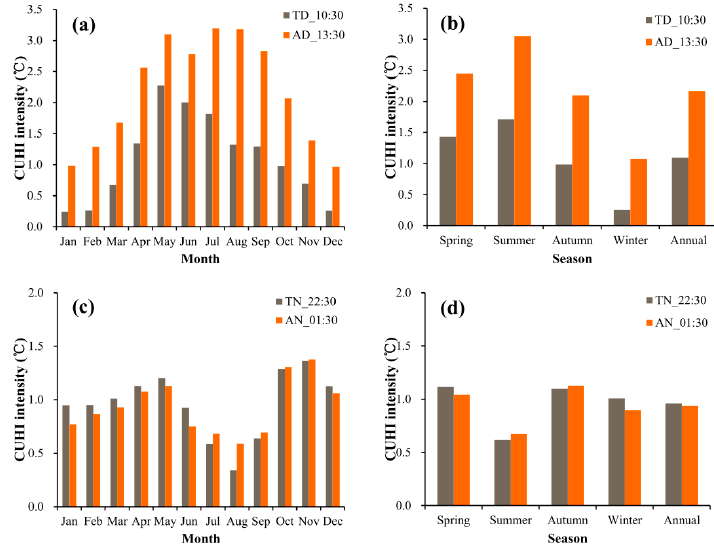
Figure 6. Multi-annual monthly and seasonal mean daytime and nighttime CUHI intensity calculated from satellite-estimated air temperature at the four Terra/Aqua-MODIS overpasses in Shanghai during the period 2000–2013 for Terra and 2002–2013 for Aqua. ( a ) monthly mean daytime CUHI intensity; ( b ) seasonal mean daytime CUHI intensity; ( c ) monthly mean nighttime CUHI intensity; and ( d ) seasonal mean nighttime CUHI intensity.